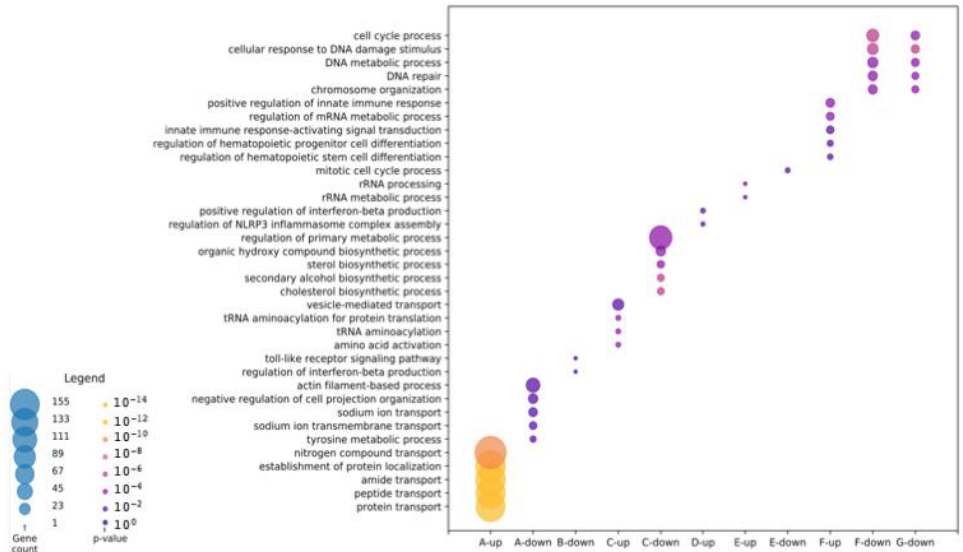
Figure 3. Gene ontology analysis highlights the different biological processes regulated by T 3 and CORT and the crosstalk between the two hormones.